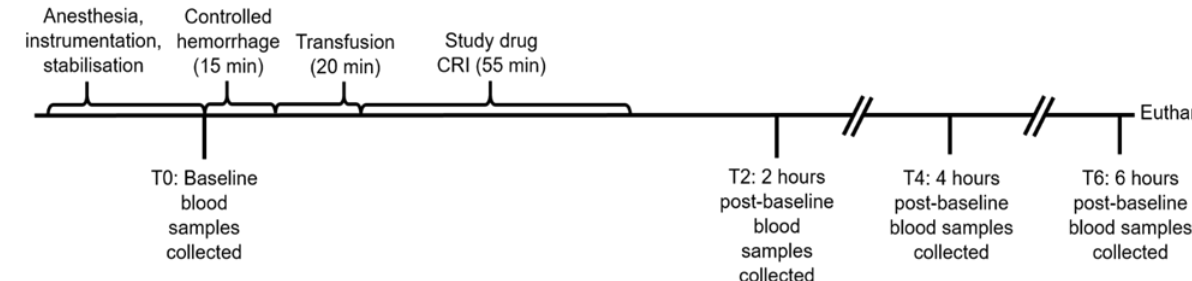
Figure 1. Timeline of experimental model. Baseline blood samples included EDTA, lithium heparin, and serum at all time points and an additional quantity of serum for microbial studies at T6. Con- trolled hemorrhage involved the removal of 900 mL of blood from the arterial catheter. Transfusion involved 15 mL/kg of allogenic, stored, packed red blood cells. The study drugs were deferoxamine in 20 mL of saline (treatment group, n = 10) or 20 mL of saline alone (control group, n = 10).